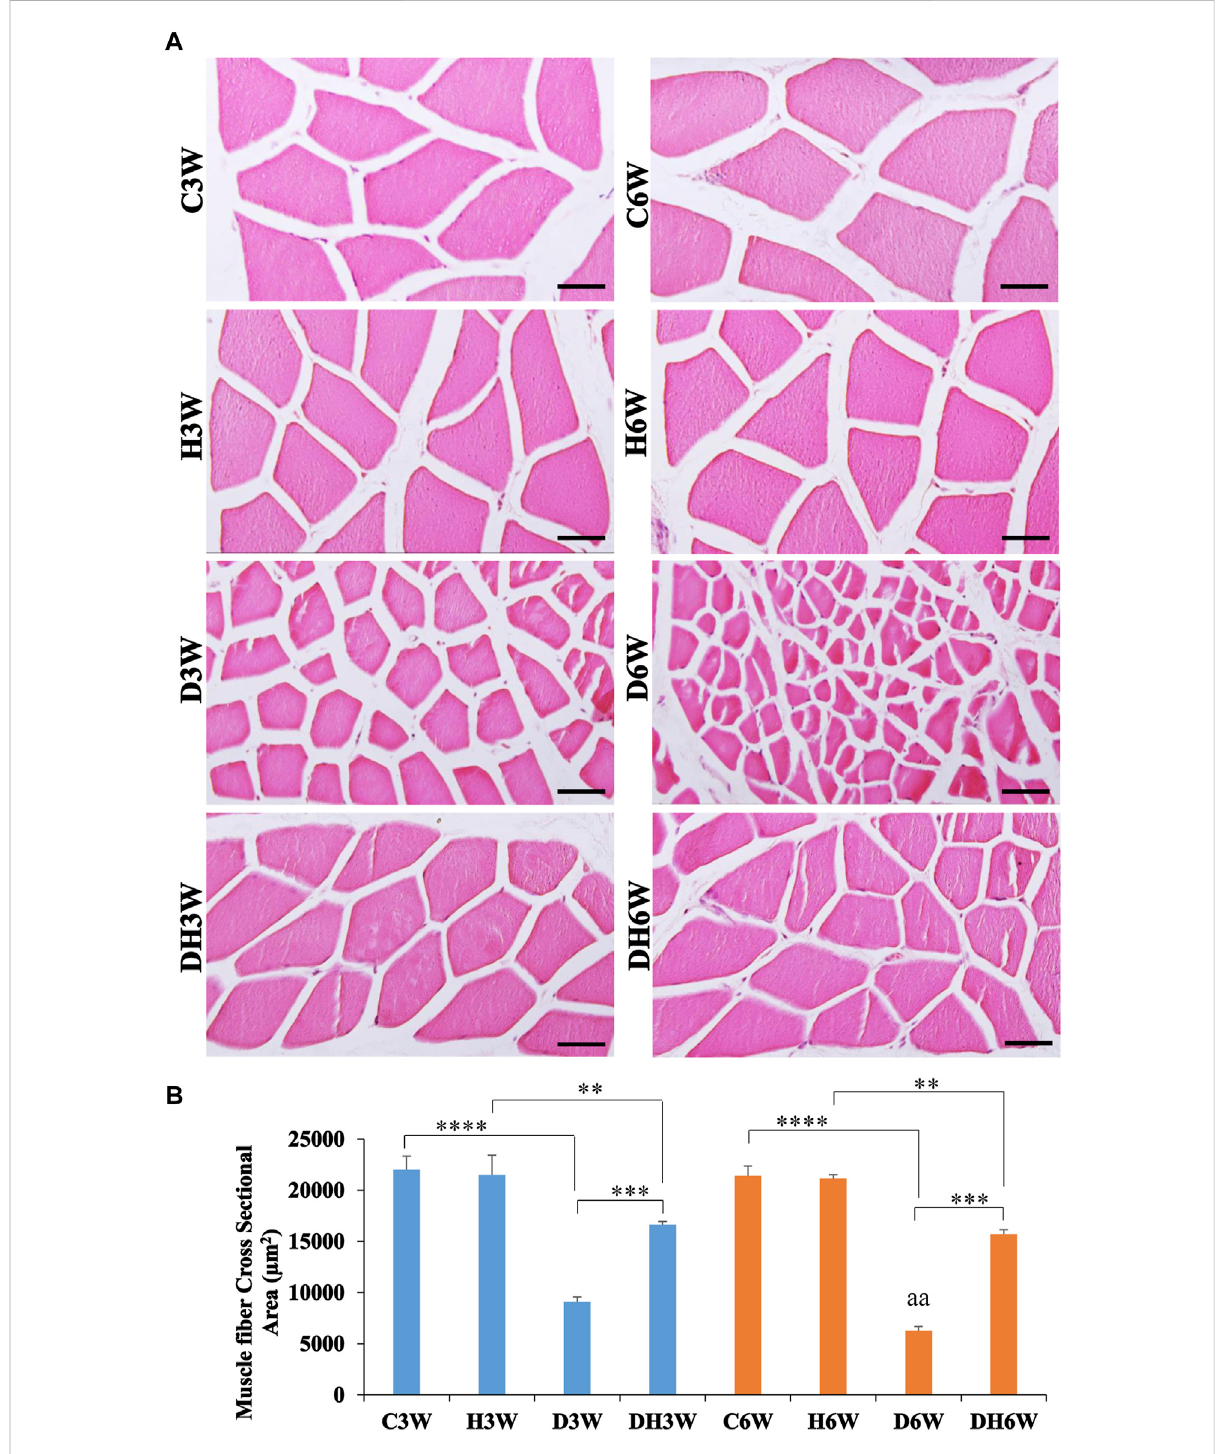
FIGURE 4 (A) Representative photomicrographs of cross sections muscle stained with H&E stain and (B) Cross-sectional area of muscle fi bers in different groups. Note the atrophied muscle fi bers in D3W, which are further atrophied in D6W and such muscle fi ber atrophy was reduced in DH3W and DH6W groups. Note the signi fi cantly decreased cross-sectional area of muscle fi bers in D3W and DH3W compared to C3W and H3W respectively and it was signi fi cantly increased in DH3W compared to D3W. A similar trend of the cross-sectional area of muscle fi bers was also found in the long-term experiment. Scale bar = 50 µm. (**, p < 0.01; ***, p < 0.001; ****, p < 0.0001, D3W vs. D6W- aa p < 0.01; One-way ANOVA, Bonferroni multiple comparison tests, n = 6 in all